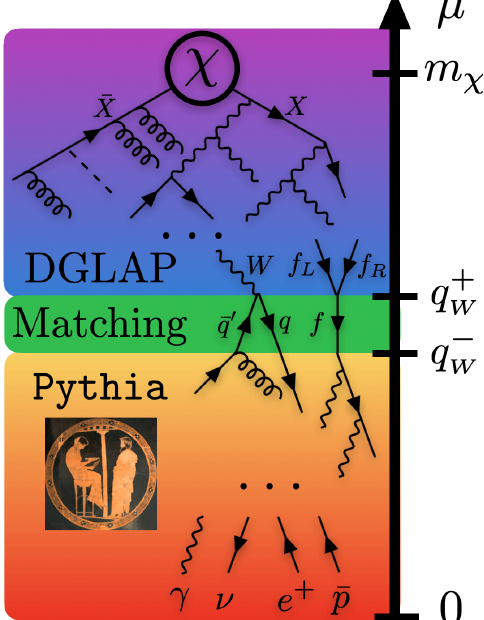
Figure 2 . A cartoon of the three steps used to calculate the UV to IR evolution. An initial 2-body final state resulting from a hard interaction of χ → X ¯ X is DGLAP evolved down to q + just above the weak scale. At q + , states with masses above the electroweak scale are integrated W out. Finally, at q − these results are matched onto Pythia which handles the subsequent evolution W and hadronization